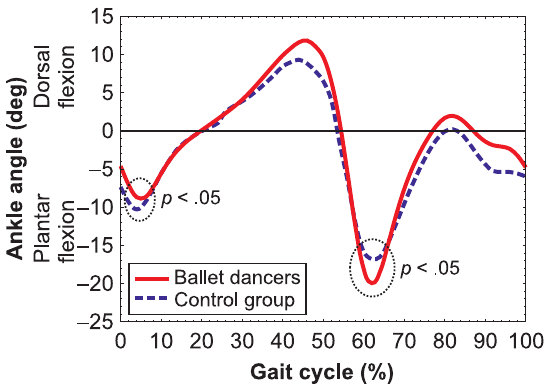
Figure 3. Hip movement in the sagittal plane during gait in dancers and the control group